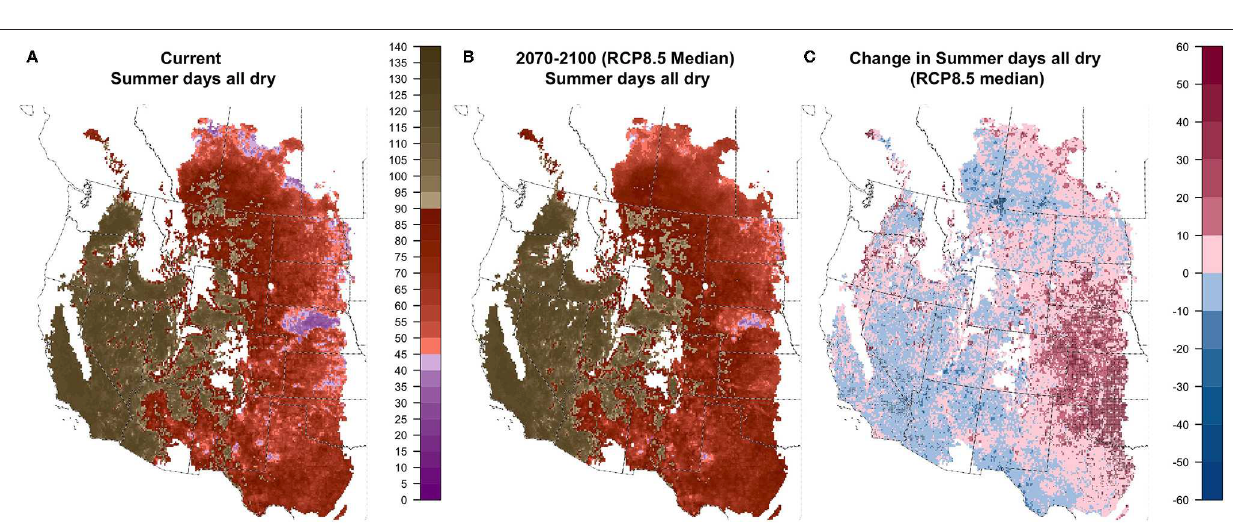
FIGURE 7 | Current (A) , future ( B ; 2070–2100; RCP8.5 median model), and change (C) in CDRY SUMMER : consecutive summer days with all layers